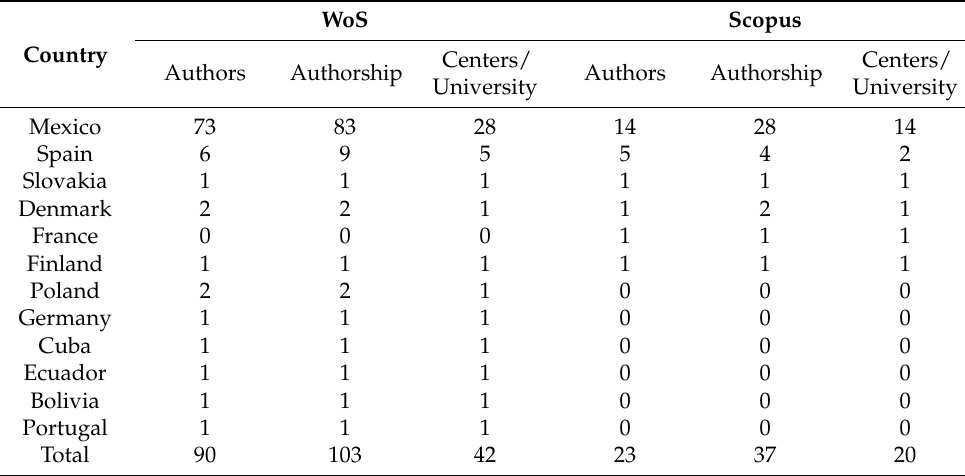
Table 6. Main countries according to the affiliation of their